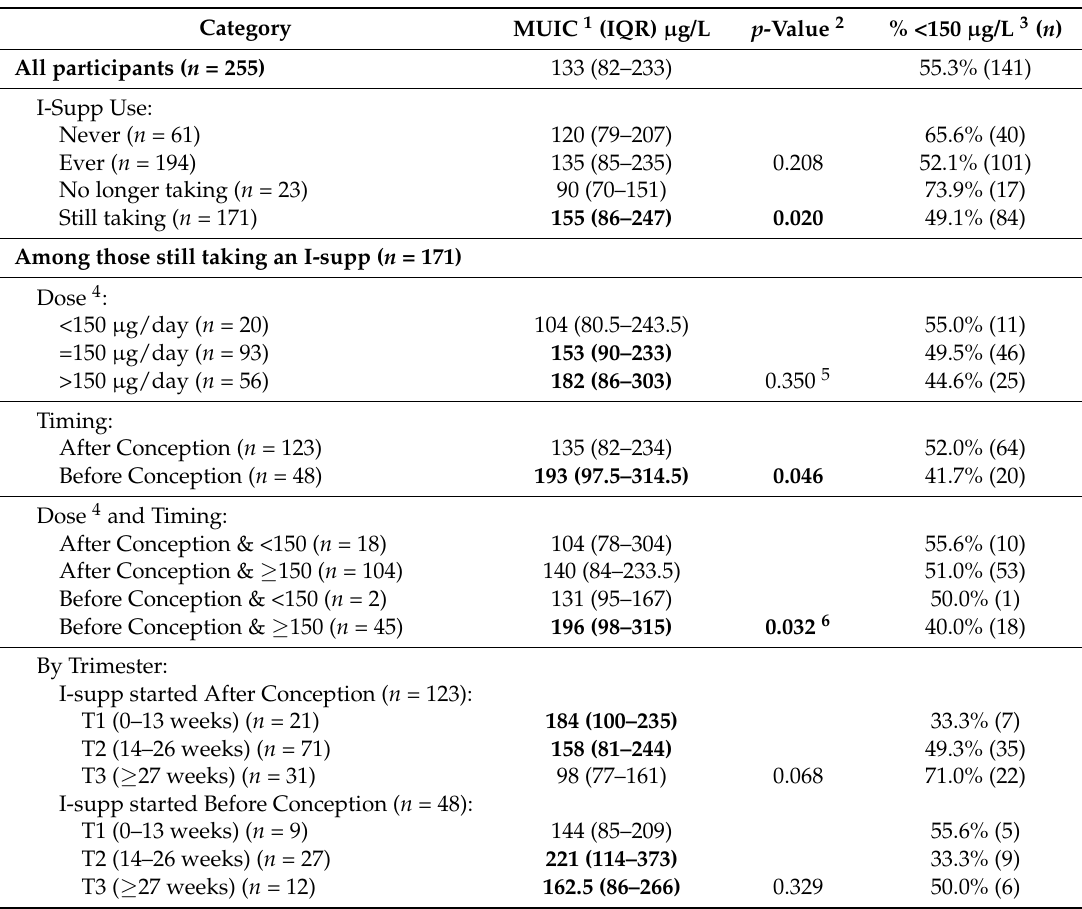
Table 2. Iodine status of pregnant Tasmanian women categorised by iodine supplement use, dose and timing, and trimester at enrolment. Defined by median urinary iodine concentration (MUIC) and by percentage and number <150 µ